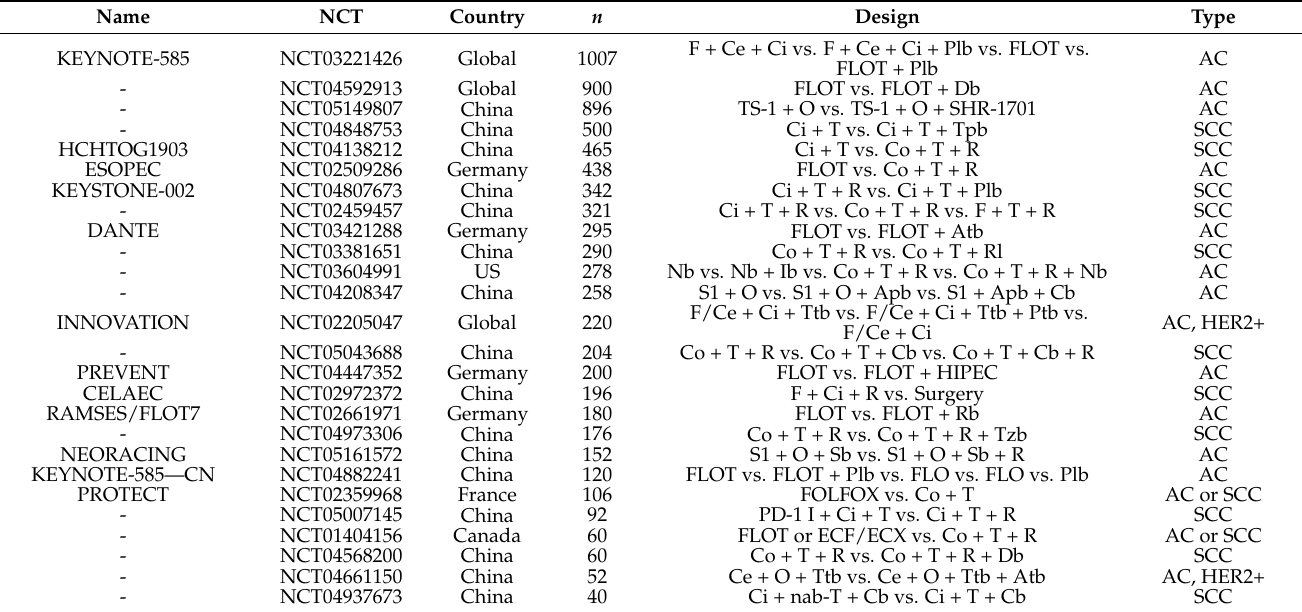
Table 5. Registered Randomized Controlled Trials (RCTs)